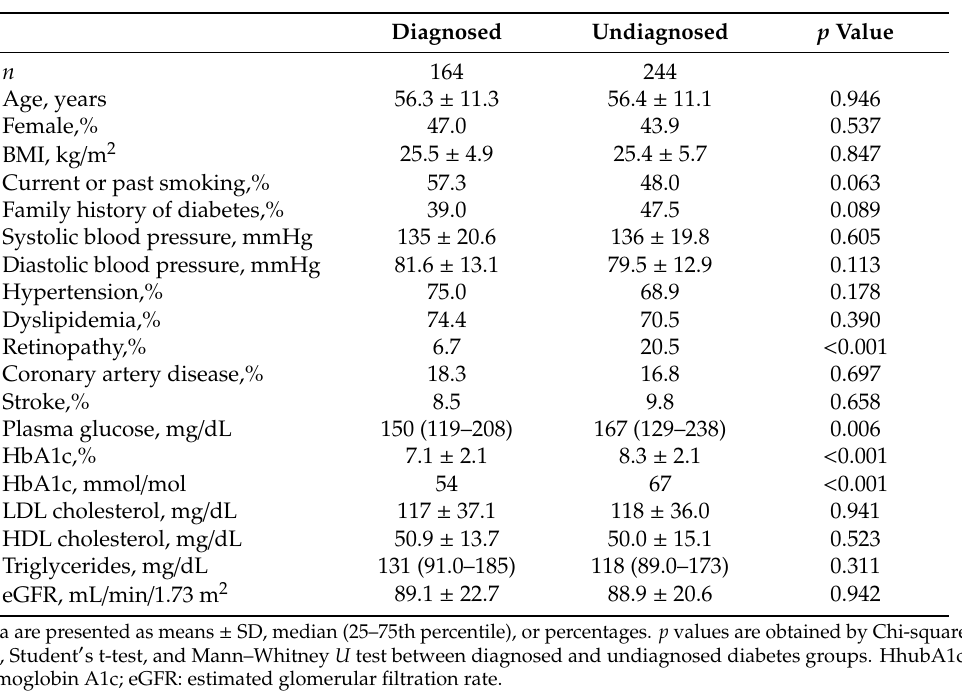
Table 1. Baseline characteristics of study participants.